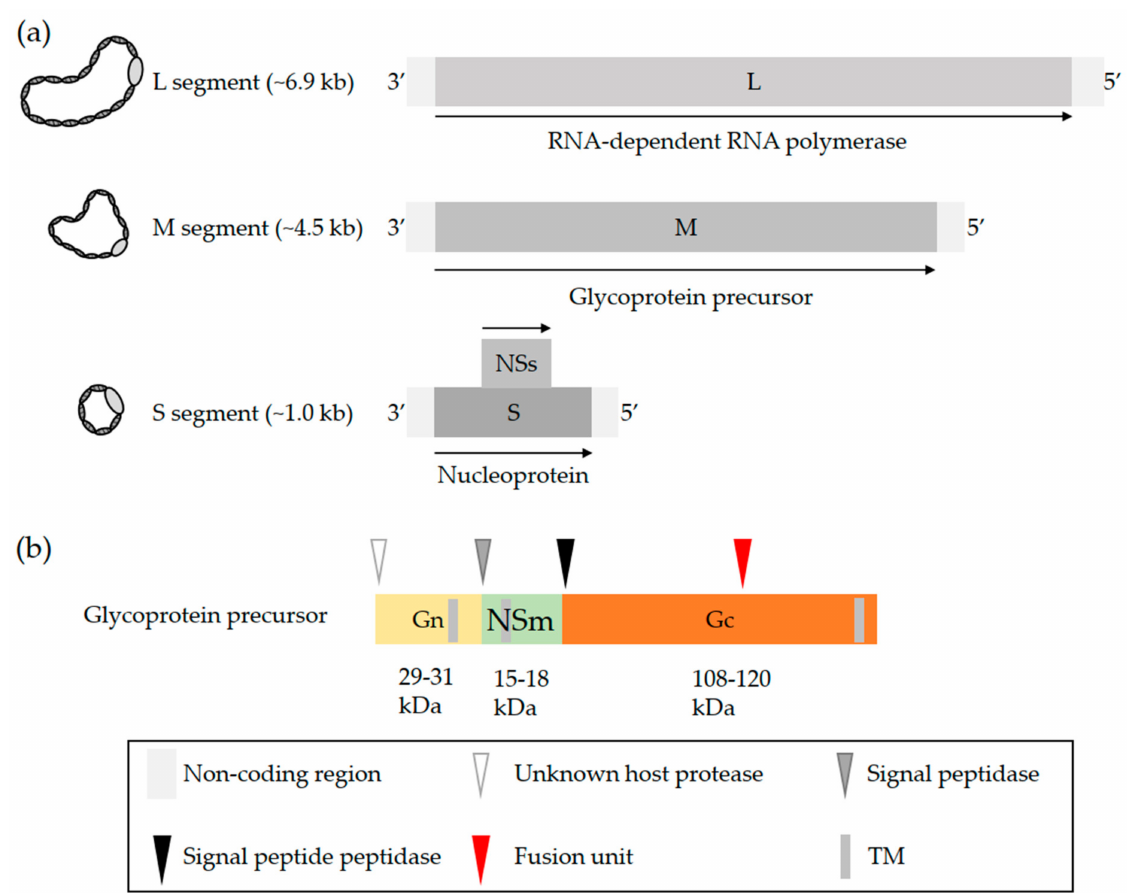
Figure 1. OBV genome and the glycoproteins Gn and Gc. ( a ) Generic representation of an OBV genome. The name of the three viral genomic RNA segments refers to their size, i.e., S (small), M (medium), and L (large). ( b ) Schematic representation of the OBV M precursor polypeptide. Arrow heads show the sites proteolytically cleaved by host cell proteases. The red arrowhead indicates the location of the fusion peptide based on bioinformatics predictions and biochemical analysis of LACV glycoproteins [35–37]. Abbreviation: TM, transmembrane